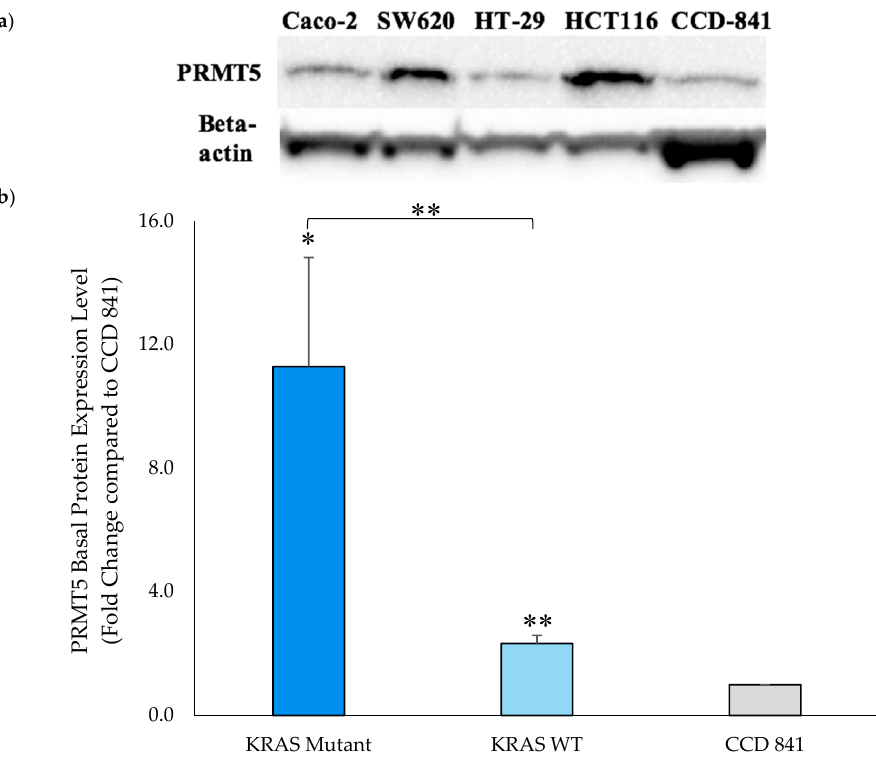
Figure 3. PRMT5 is shown to be further overexpressed in the KRAS mutant CRC cells at the translational level by Western blot analysis. ( a ) Western blot assay results displaying PRMT5 and corresponding beta-actin bands; ( b ) Quantified Western blot assay results showing that PRMT5 protein is 4.8-Fold ( p < 0.01) further overexpressed in the KRAS mutant CRC cells when compared to the KRAS WT CRC cells. Data are expressed as means + SD from two independent experiments using four CRC cell lines (2 KRAS mutant, 2 KRAS WT), as well as one normal colon cell line. The uncropped Western blot membranes can be seen in Figure S1. Data for the individual cell lines can be seen in Figures S2 and S3. * represents p < 0.05; ** represents p < 0.01.